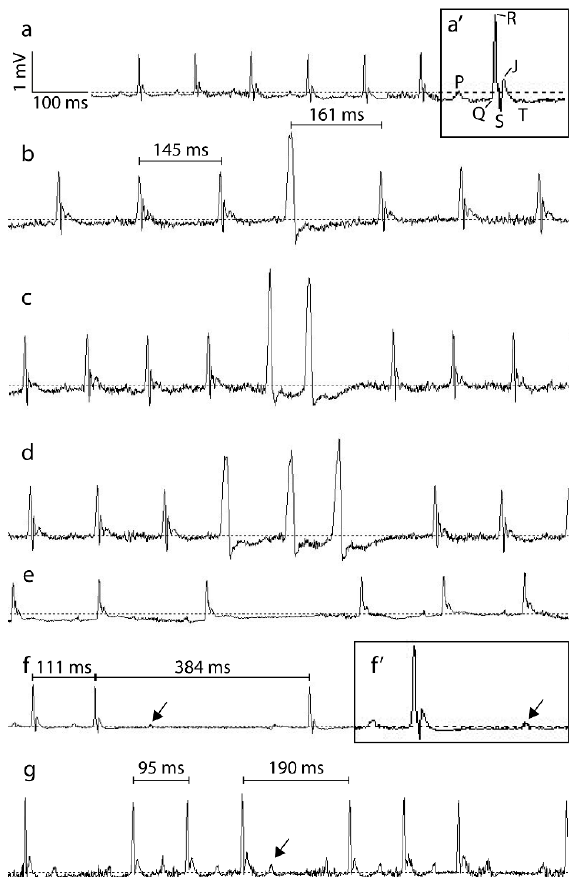
Figure A2. Representative traces of arrhythmic events. ( a ): murine ECG trace in sinus rhythm. ( a’ ): two-fold magnification of the murine ECG trace of a single heart beat in sinus rhythm marked with the different components: the P-wave (P), the QRS-complex (QRS), the J-wave (J), and the T-wave (T). ( b ): murine ECG trace with extrasystole, single. An extrasystole is described as an extra heart beat either originating from supraventricular, ventricular or near junctional cardiac tissue. This is represented as an extra QRS-complex with an abnormal morphology, mostly followed by a deviant compensatory longer RR-interval (indicated with brackets). ( c ): murine ECG trace with extrasystole, doublet. A doublet is represented as two consecutive extrasystoles. ( d ): murine ECG trace with three consecutive extrasystoles. ( e ): murine ECG trace with sinus arrest. A sinus arrest is represented by a long RR-interval within the ECG trace in the absence of any ECG activity. ( f ): murine ECG trace with blocked P-wave. A blocked P-wave is represented by the presence of a P-wave (indicated with arrow) without subsequent QRS-complex. The resulting long RR-interval is not a multiple of the normal mean RR-interval. ( f’ ): two-fold magnification of a murine ECG-trace with blocked P-wave. Presence of P-wave is indicated with arrow. ( g ): murine ECG trace with AV-Block. An AV-block is represented by the presence of a P-wave (indicated with arrow) without subsequent QRS-complex. The resulting long RR-interval is a multiple of the normal mean RR-interval. The vertical and horizontal scale bar represent 1 mV and 100 ms, respectively.